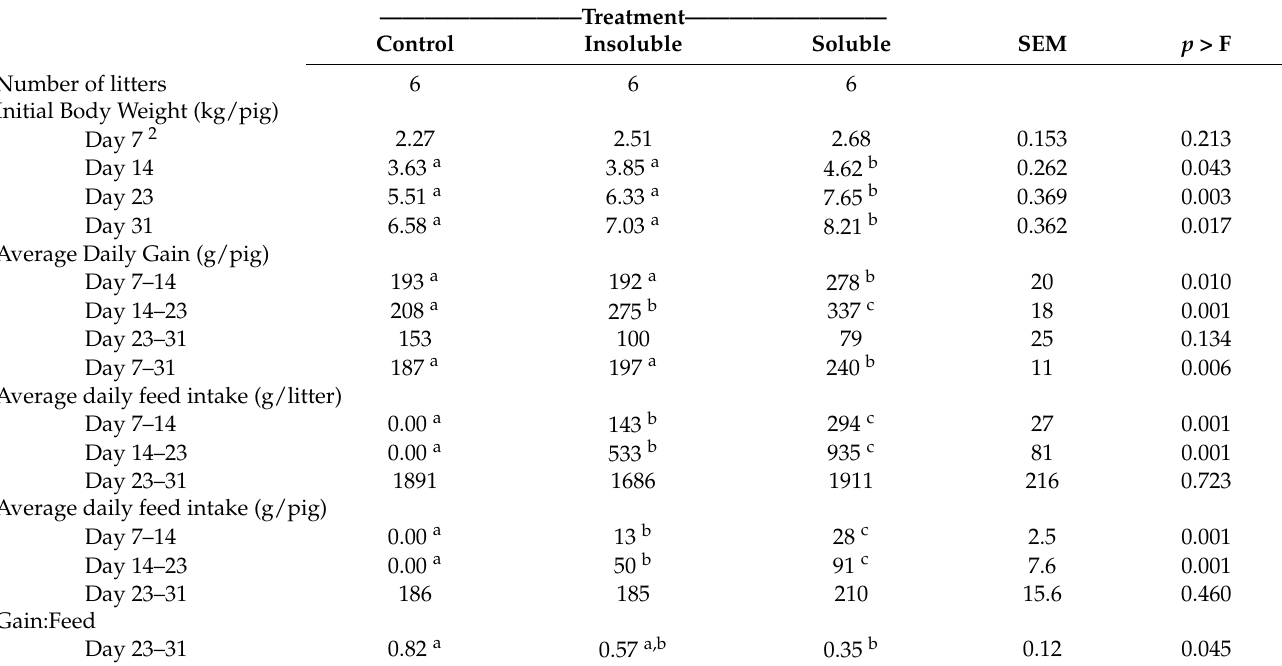
Table 2. Growth of litters fed either insoluble or soluble gruel creep diets versus non-creep-fed controls 1 . —————————Treatment————————— Control Insoluble Soluble SEM p >